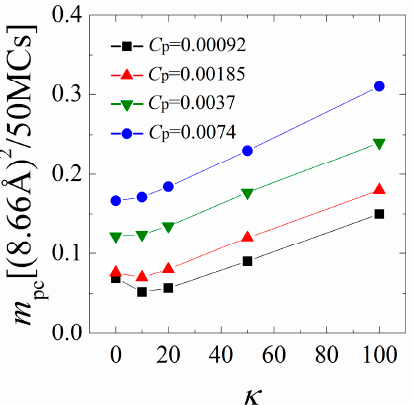
Figure 5. Mean-square-displacement (MSD) of the center of mass of the anchored polymers calculated in every 50 Monte Carlo (MC) steps as a function of chain rigidity parameter κ for various polymer concentrations. The results shown are for PC:PS:PIP 2 = 98:1:1.